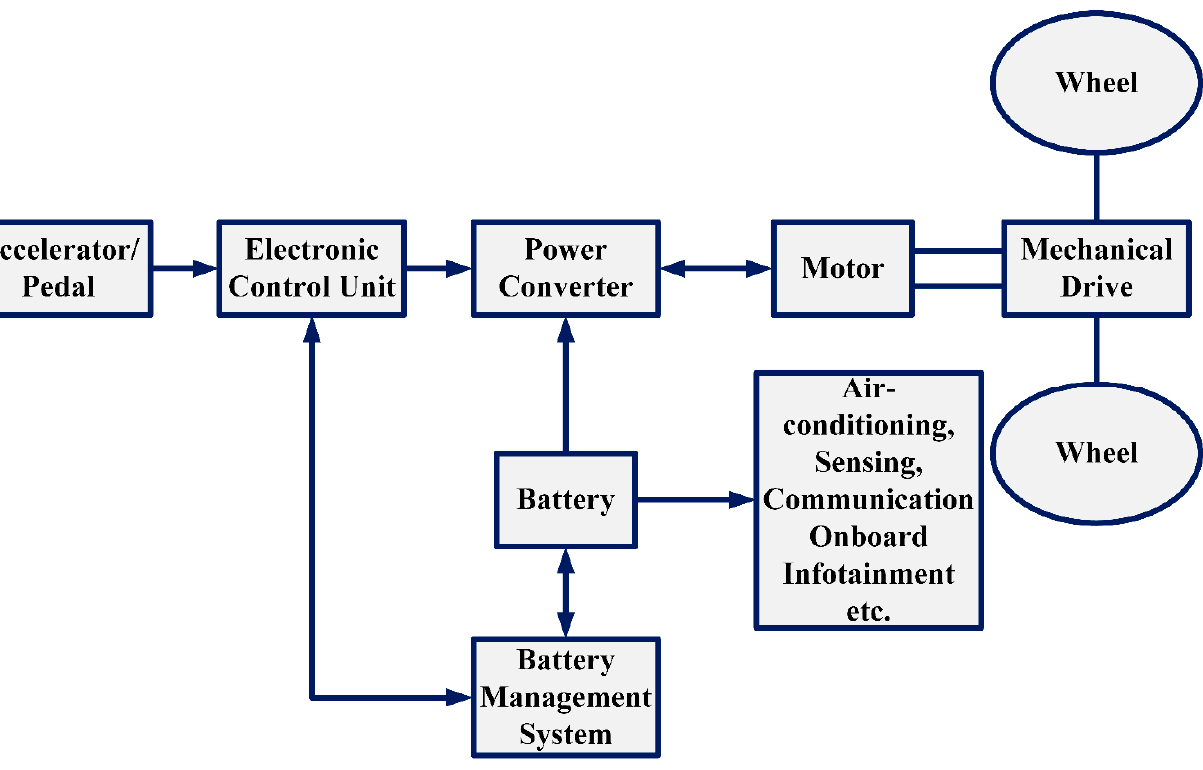
Figure 5. BMS operation inside Electric Vehicle (EV).